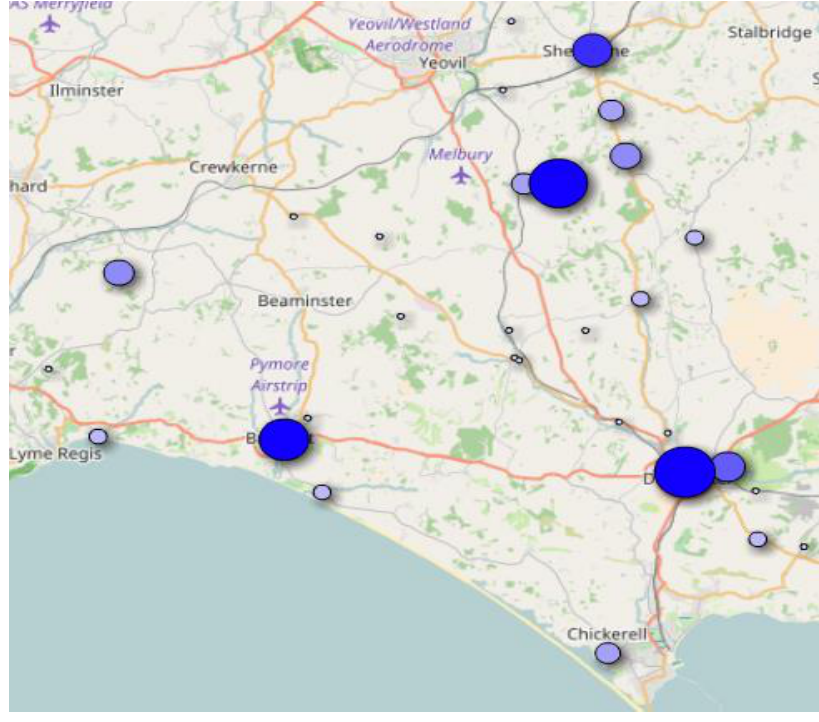
Note: The size of the ‘blobs’ gives an indication of the relative numbers of participants in given